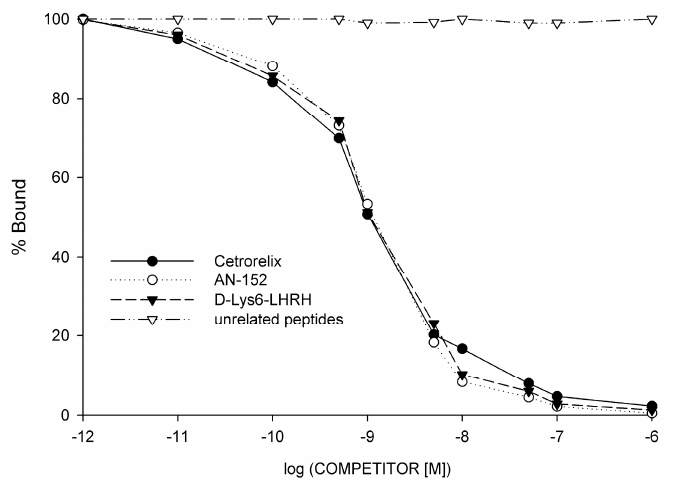
Figure 4. Representative displacement of [ 125 I][D-Trp 6 ]LHRH binding to membrane fractions of human bladder cancer specimens by increasing concentrations of LHRH antagonist Cetrorelix ( ● ), agonist [D-Lys 6 ]LHRH ( ▼ ), and cytotoxic LHRH analog AN-152 ( ○ ). Other unrelated peptides, like somatostatin, human growth hormone (hGH), growth hormone-releasing hormone (GHRH), vasoactive intestinal peptide (VIP), and epidermal growth factor ( ∆ ) did not displace the radioligand. Each point represents mean of duplicate or triplicate determinations. Table 4. Receptor binding potency (IC 50 values) of LHRH analogs to the membrane receptors of human bladder cancer cells. Compound IC 50 Values (nM)